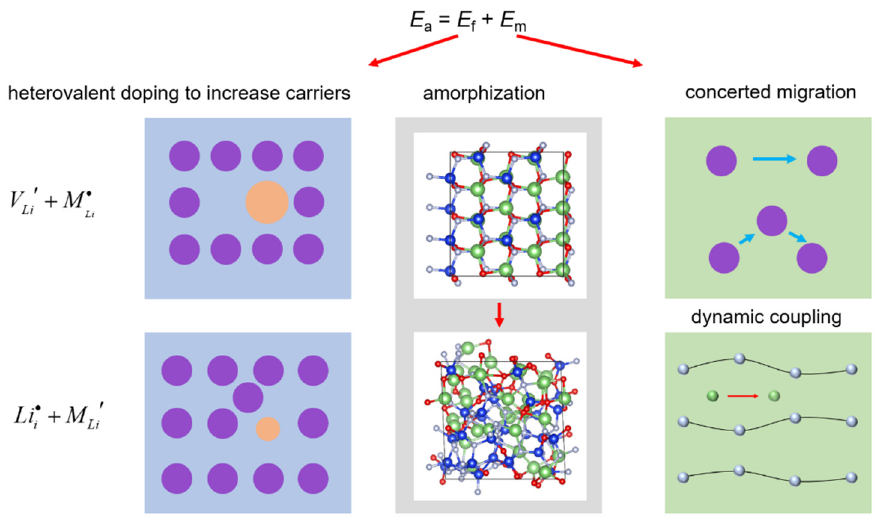
Figure 9. Strategies to improve the ionic conductivity for a candidate framework.